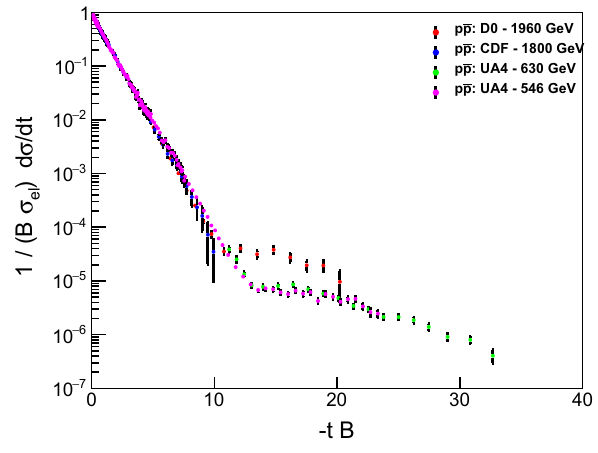
d σ Fig. 6 Approximate H ( x ) = 1 scaling of the differential cross √ B σ el dt s = 0 . 546 to 1.96 TeV. section d σ/ dt of elastic pp collisions at The scaling behaviour is valid in the exponential cone region, with the scaling function H ( x ) = exp ( − x ) . The scaling domain starts at x = 0 and extends up to x = − tB (cid:12) 10. Scaling violations are evident in the − tB ≥ 10 region, when the colliding energy increases from 546 GeV to 1.96 TeV, nearly by a factor of